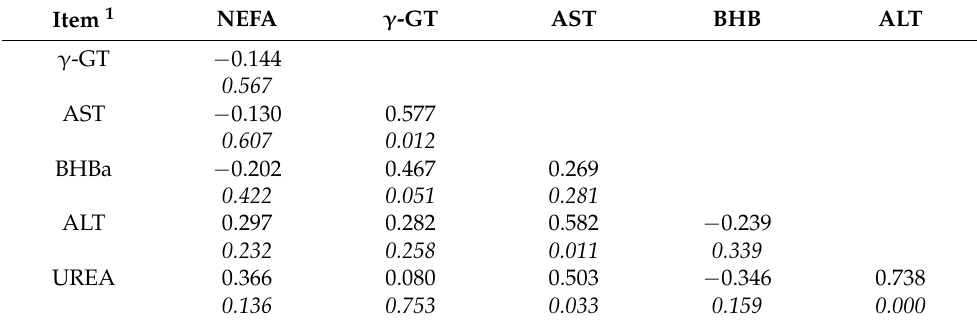
Table 5. Correlation coefficient ( ρ ) and significance ( p -value, in italics) at Pearson test between NEFA, BHBa, UREA and hepatic